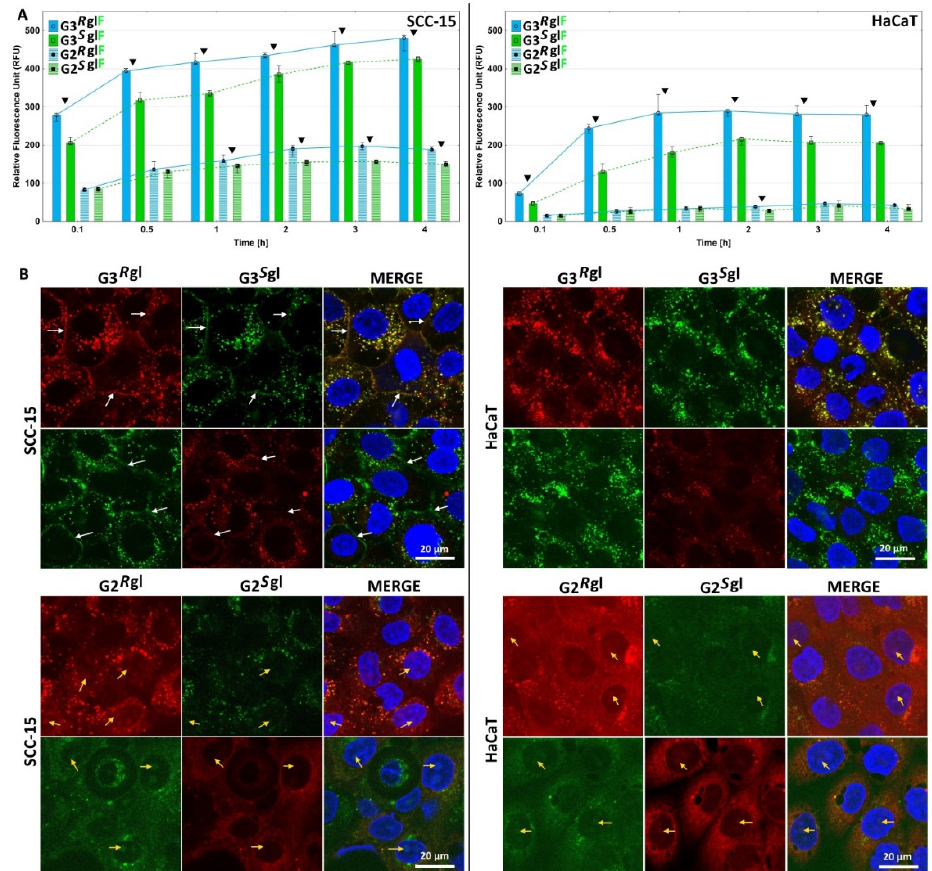
Figure 6. ( A ): Time-dependent accumulation of G3 R glF , G3 S glF , G2 R glF, and G2 S glF in immortalized human keratinocytes (HaCaTs) and squamous carcinoma cells (SCC-15). Cells were incubated with 1 µM working solutions of dendrimers for 0.1–4 h and the fluorescence signal was measured with a fluorescence microplate reader at 485 nm/530 nm (exc./em.). Results are expressed as medians of relative fluorescence units, and the whiskers are lower (25%) and upper (75%) quartile ranges. ▼ p ≤ 0.05; Mann–Whitney U-test ( S against R enantiomers). ( B ): Confocal microscopy images of HaCaT and SCC-15 cells incubated for 4 h with 100 nM solutions of dendrimers in the respective pairs ( G3 R glR –G3 S glF ), ( G3 R glF –G3 S glR ), ( G2 R glR –G2 S glF ), ( G2 R glF – G2 S glR ). White arrows indicate dendrimers bounded with cell membranes. Yellow arrows show the presence of dendrimers in nucleoli.